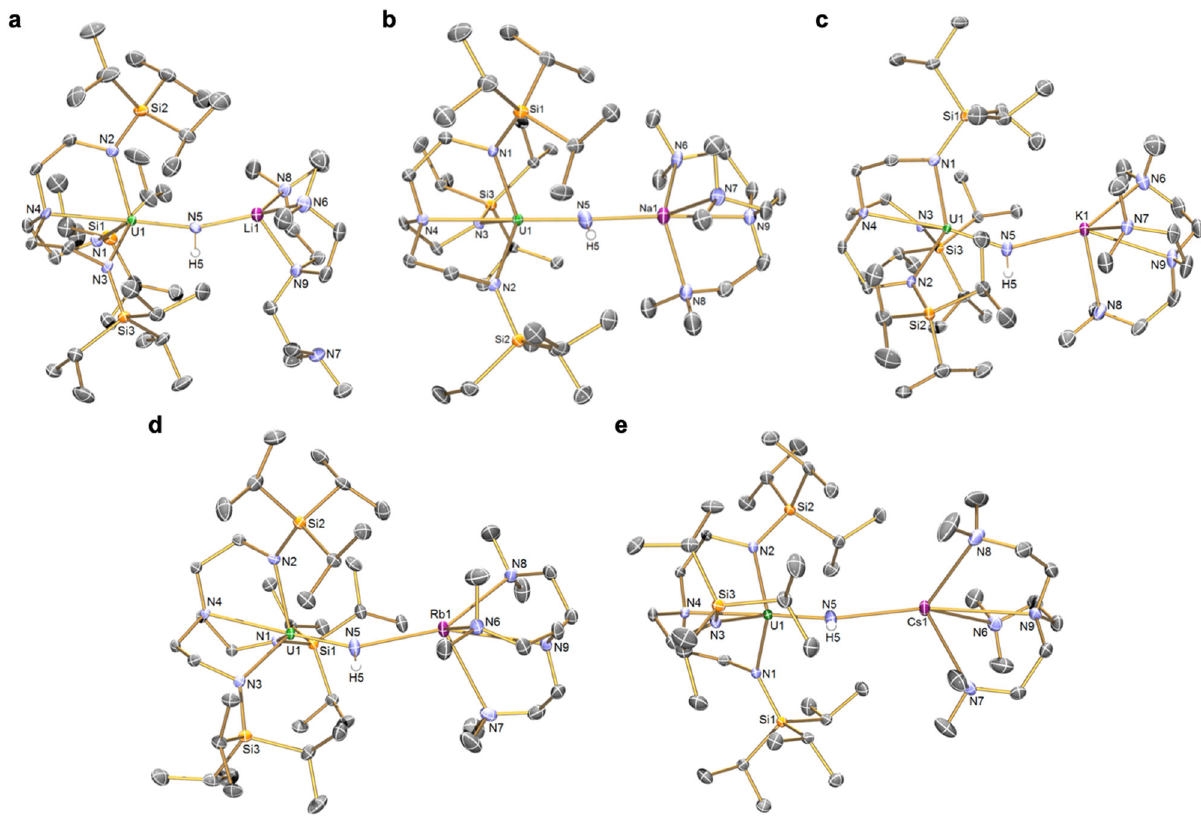
Fig. 2 Solid-state single crystal structures of uranium(IV)-imido (3M) complexes at 150 K with 40% probability displacement ellipsoids. a complex 3Li . b complex 3Na . c complex 3K . d complex 3Rb . e complex 3Cs . In each case all non-imido hydrogen atoms, lattice solvent molecules, and disorder components are omitted for clarity.